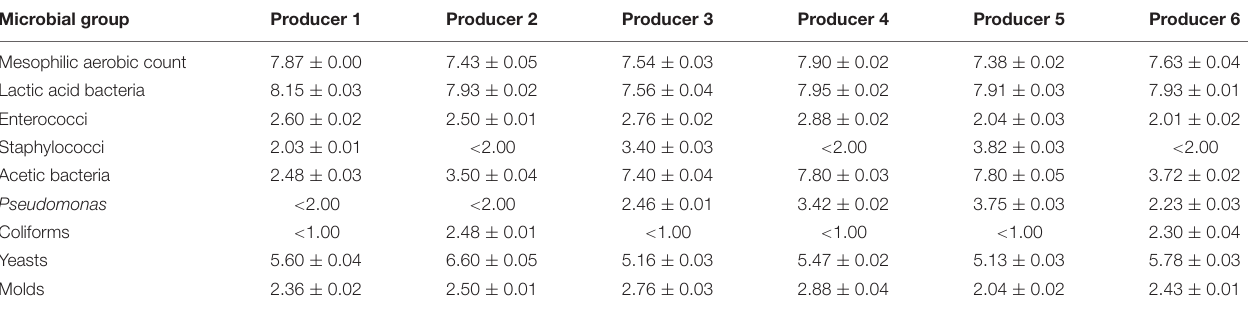
Data are expressed as Log CFU/g (mean of three repetitions ± Standard Deviation).